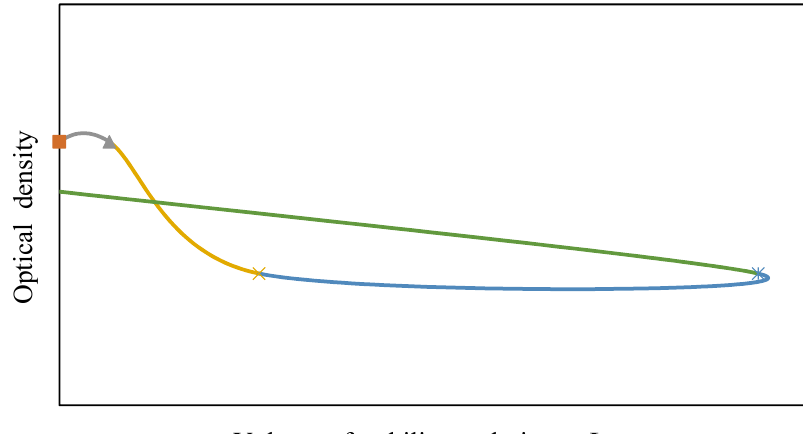
Figure 3. Dependence of optical density on the volume of PVA stabilizer.